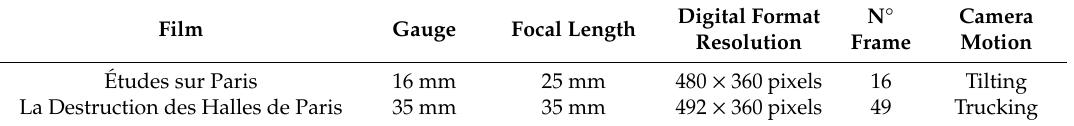
Figure 24. A selection of frames from the film footage: ( a ) “Études sur Paris”; ( b ) “La Destruction des Halles de Paris”. Figure 25. Results from Structure-from-Motion (SfM) pipeline: ( a ) reconstruction of the Tour Saint Jacques; ( b ) reconstruction of the Halles.